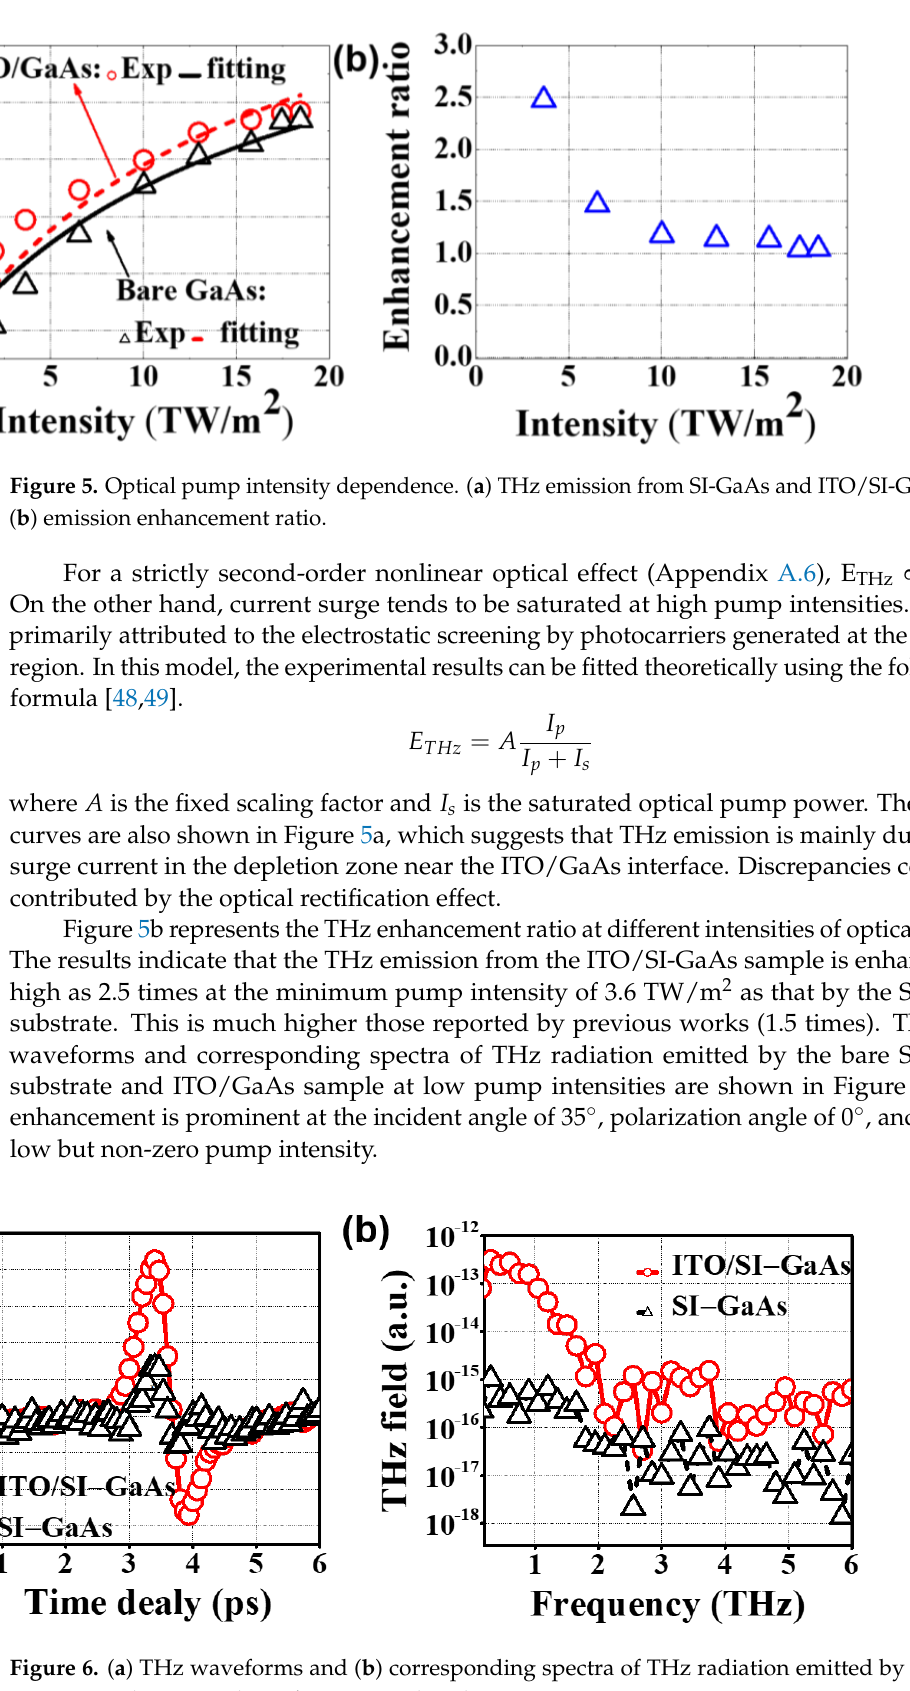
SI − GaAs substrate and ITO/GaAs sample at low pump